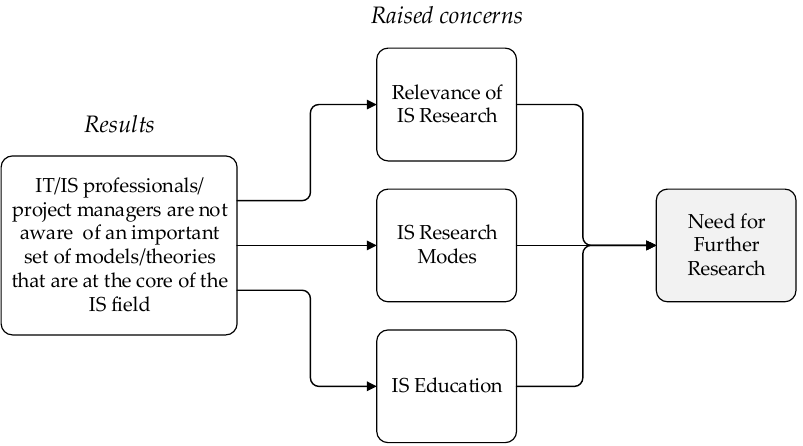
Figure 7. Concerns arising from IT/IS professionals’/project managers’ lack of awareness of IT adoption models/theories in projects.